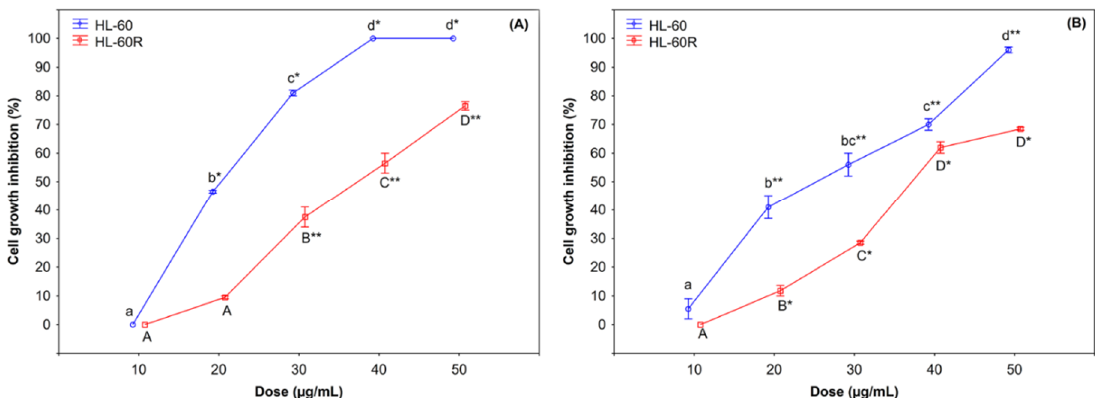
Figure 4. Cytotoxic activity of C. juttae ( A ) and K. beharensis ( B ) essential oils (Eos) on leukemia HL- 60 and HL-60R cell lines . Cell viability was assessed by MTS. Data are expressed as mean ± standard error of at least three different experiments performed in triplicate. Different letters represent significant differences (Tukey test) in cytotoxic activity among the concentrations of each cell line ( C. juttae : HL-60 p < 0.01 and HL-60R p < 0.05; K. beharensis : HL-60 p < 0.05 and HL-60R p < 0.01). Differences when treatments are compared to the controls: * p < 0.05; ** p < 0.01. Table 2. IC 50 values of the two cell lines treated with the essential oils of C. juttae and K. beharensis.